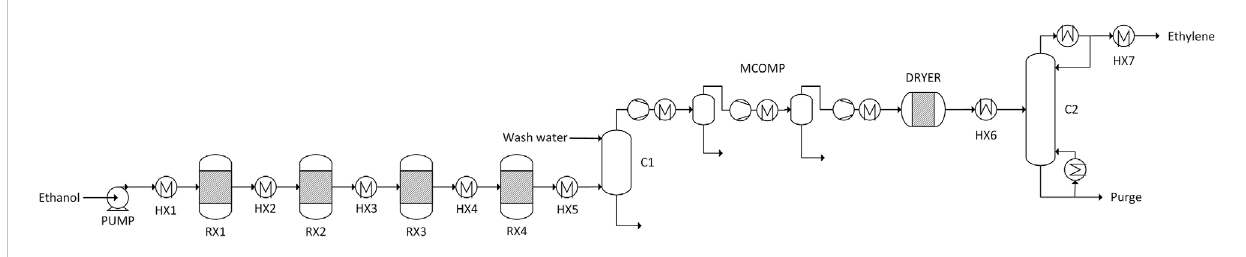
FIGURE 5 Flowsheet of the ethanol to ethylene process.